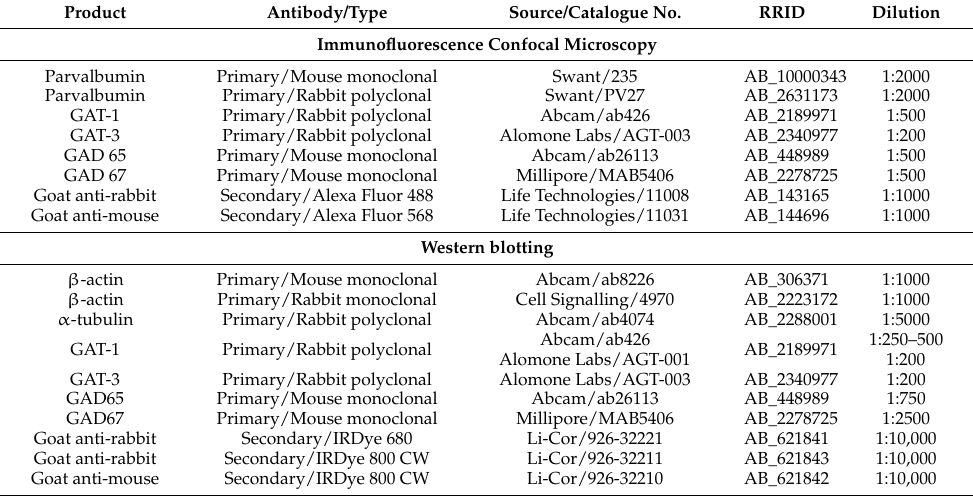
Table 1. Primary and secondary antibodies used in this study for immunofluorescence confocal microscopy and Western